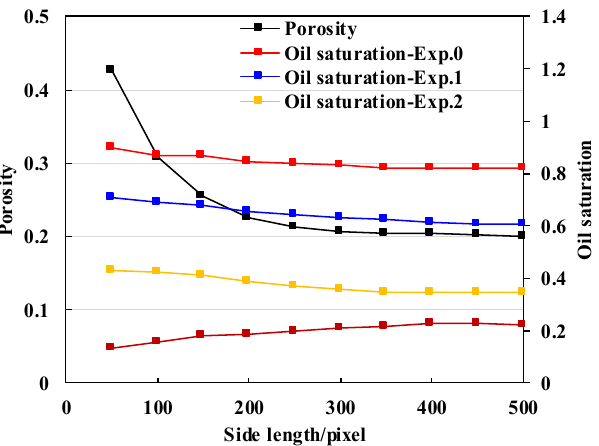
Figure 6. Variation of porosity and oil saturation in different states with various sub-sample volumes.